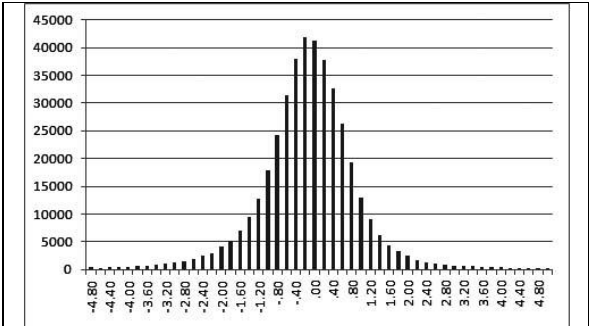
Fig. 12 : frequency distribution of height differences between overlapping stereo models